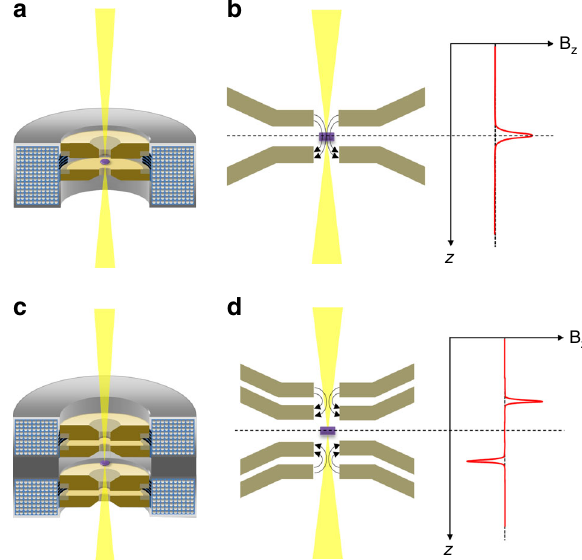
Fig. 1 Schematic illustration of magnetic objective lens systems for atomic- resolution TEMs/STEMs. a Schematic cross section of a conventional magnetic objective lens. Samples (shown as a purple disk) are placed between the upper and lower polepieces (in gold color). b Schematic illustration showing the z -component magnetic fi eld (B z ) distribution across the upper and lower polepieces when we excite the magnetic objective lens system. The maximum B z is found near the sample position. c Schematic cross section of the new magnetic fi eld-free objective lens system developed in this study. This lens system is composed of two round lenses, and samples are placed in between the FOL and the BOL lenses. The polepieces and coils of the FOL and BOL are exactly in the mirror symmetric con fi guration with respect to the sample plane, but the polarities of their excitations are opposite, resulting in an anti-symmetric magnetic fi eld distribution across the sample plane. d Schematic illustration shows the B z distribution across this new objective lens. The B z can be canceled out at the sample position, while the strong magnetic fi eld needed for forming an atomic size electron probe can be located as close as possible to